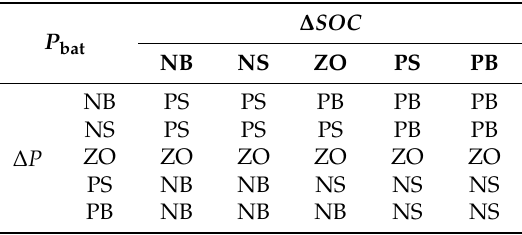
Table 2. Fuzzy logic rule base.